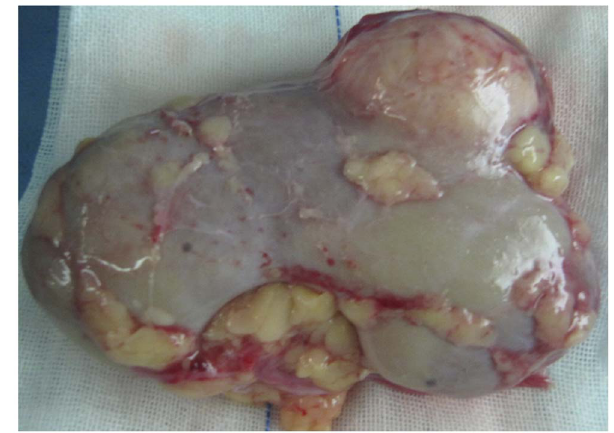
Figure 4. Kidneys with small renal cancer after perfusion with 4 6 C UW solution. All three renal cancers were less than 4.8 cm in diameter, without visible necrosis, and pathologically diagnosed as Fuhrman Grade 2 of clear cell renal cell carcinoma